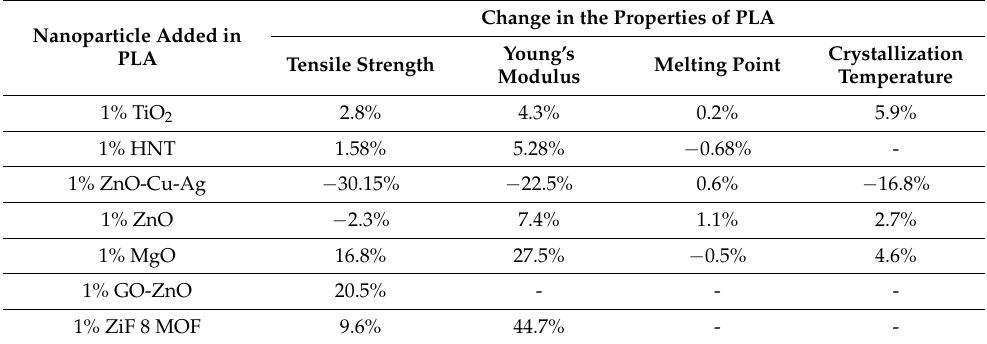
Table 5. Influence of nanoparticles on the properties of PLA